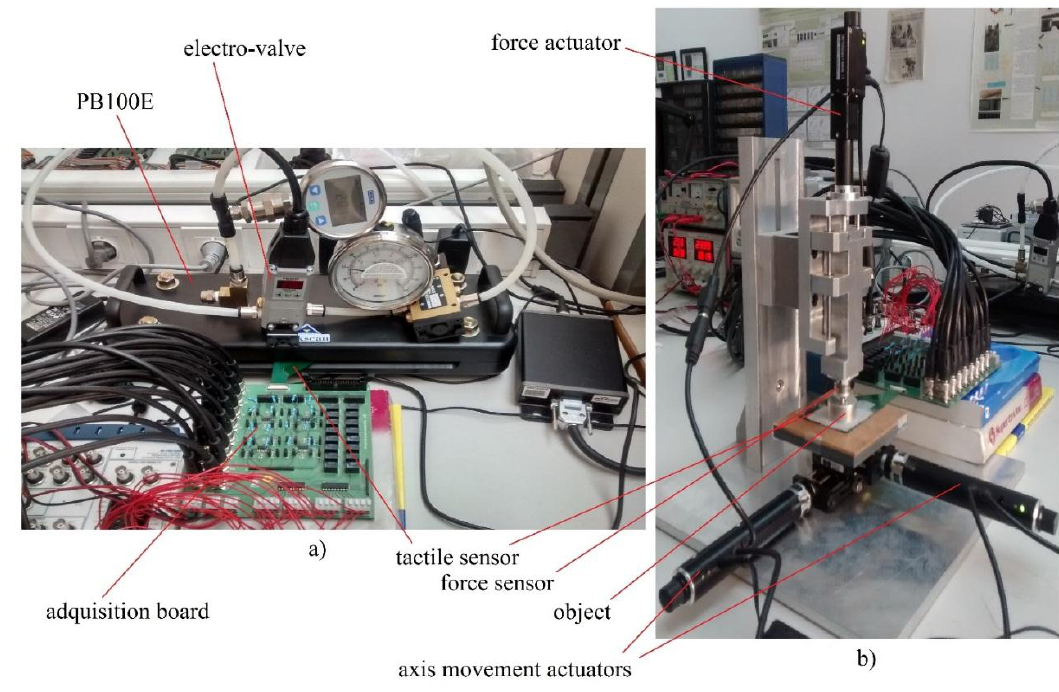
Figure 3. ( a ) Pneumatic commercial setup Tekscan PB100E; ( b ) Motorized stage.